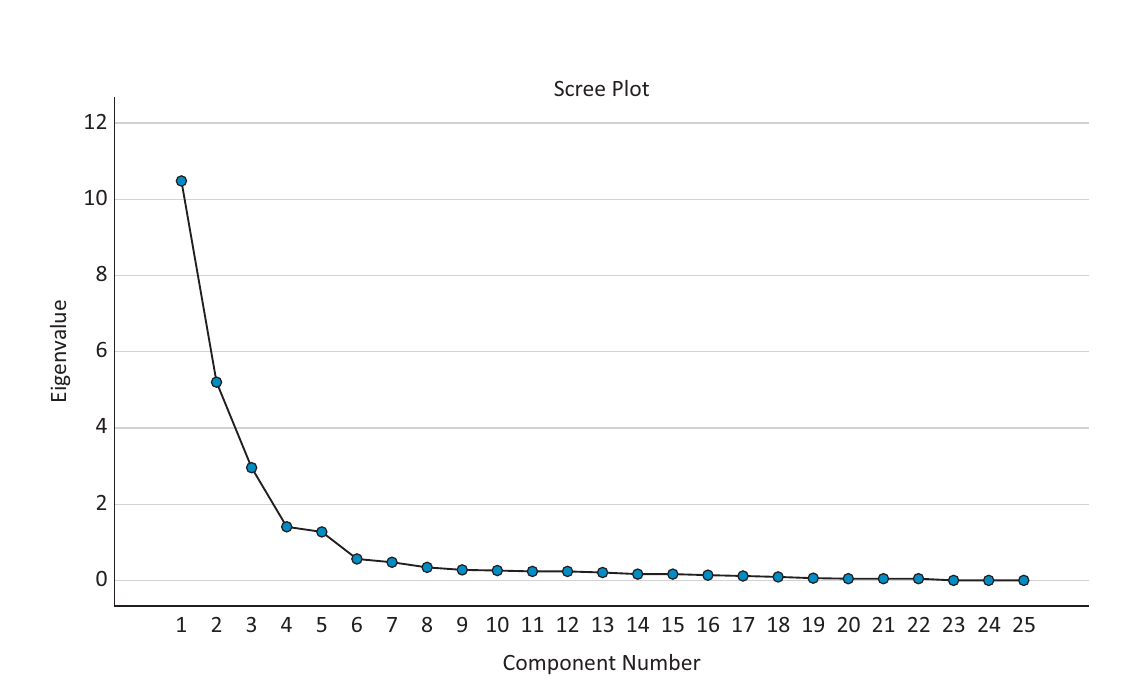
Figure 1. Scree plot showing eigenvalues of the